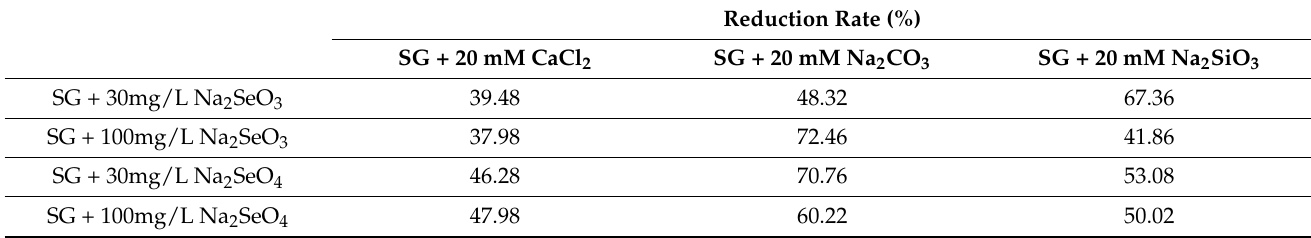
Table 5. The soluble Se reduction rate in the immersion test.